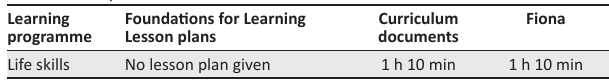
TABLE 2: Comparison of the allocation of times in different sources in Fiona’s case.